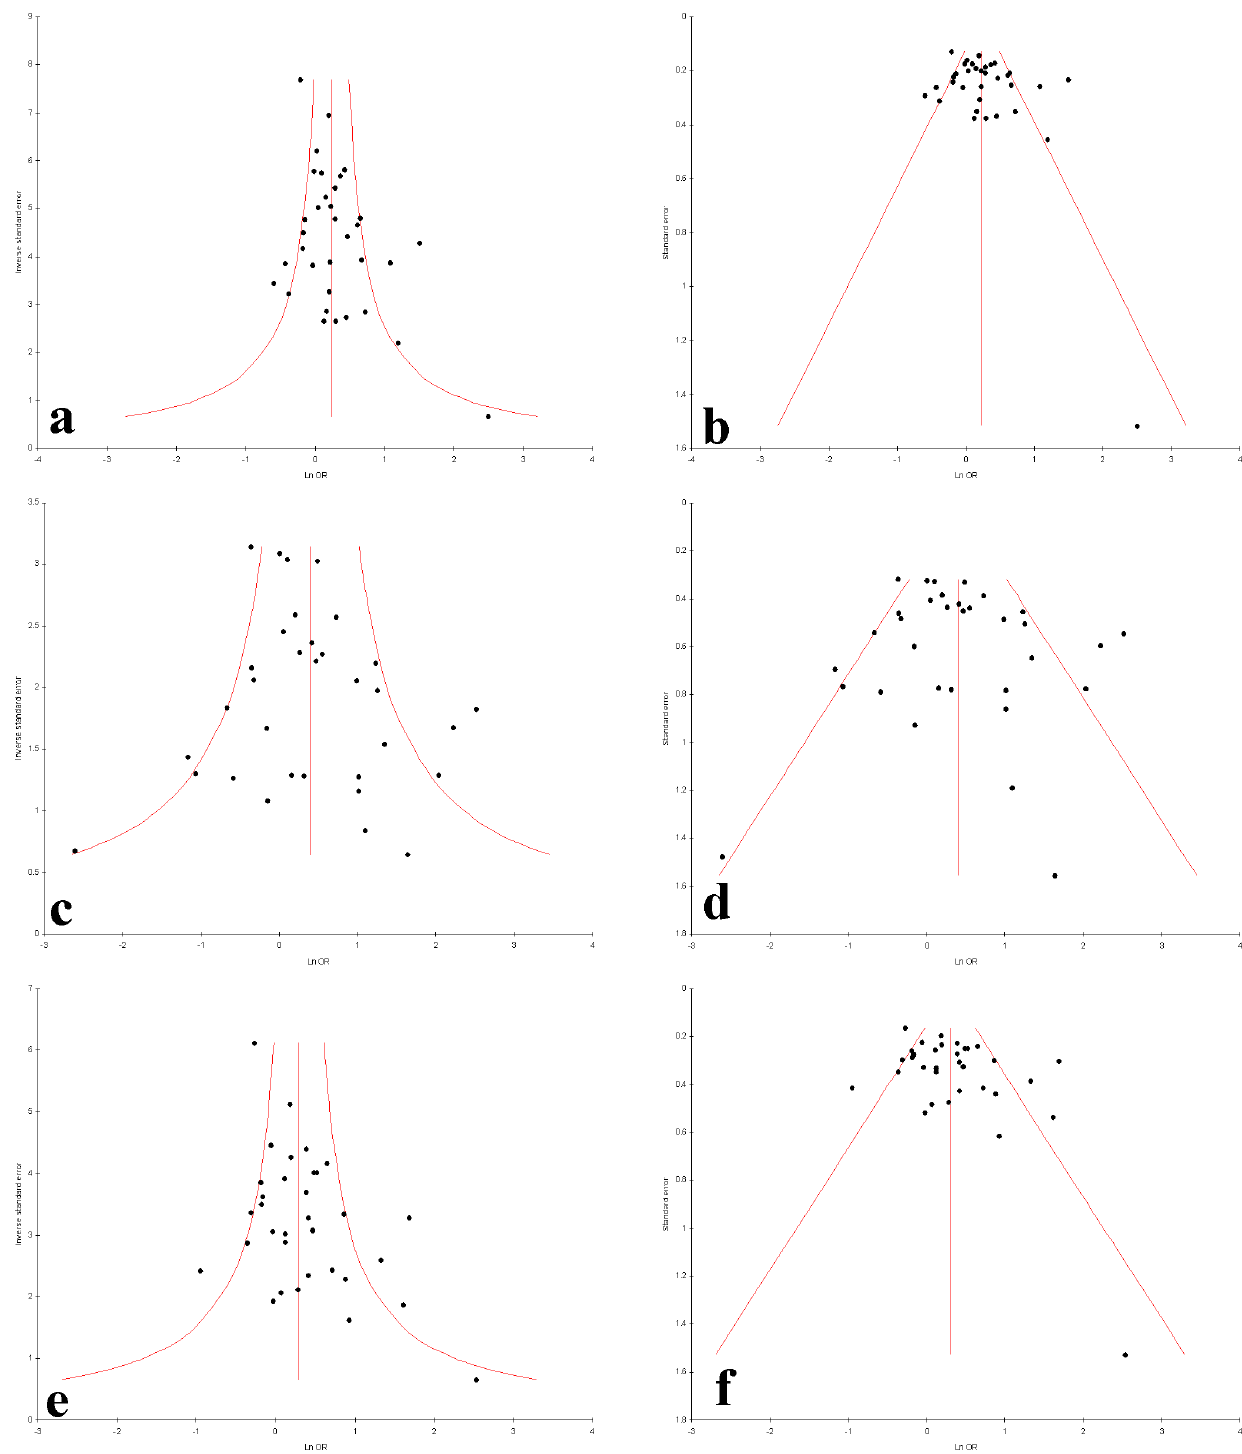
Figure 8. Funnel plots a 2 f. a. Precision by log odds ratio for additive model; b. standard error by log odds ratio for additive model; c. precision by log odds ratio for co-dominant model; d. standard error by log odds ratio for co-dominant model; e. precision by log odds ratio for dominant model; f. standard error by log odds ratio for Dominant model. doi:10.1371/journal.pone.0108552.g008 occurrence of developmental defects, like neural tube defects (NTD), congenital heart defects, limb defects, and orofacial clefts [60]. published accessing MTHFR as risk factor to various diseases/